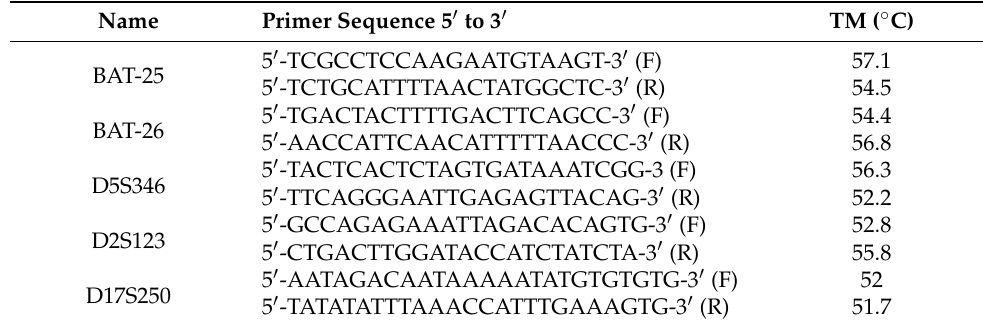
Table 2. Bethesda panel primer sequences for microsatellite analysis.